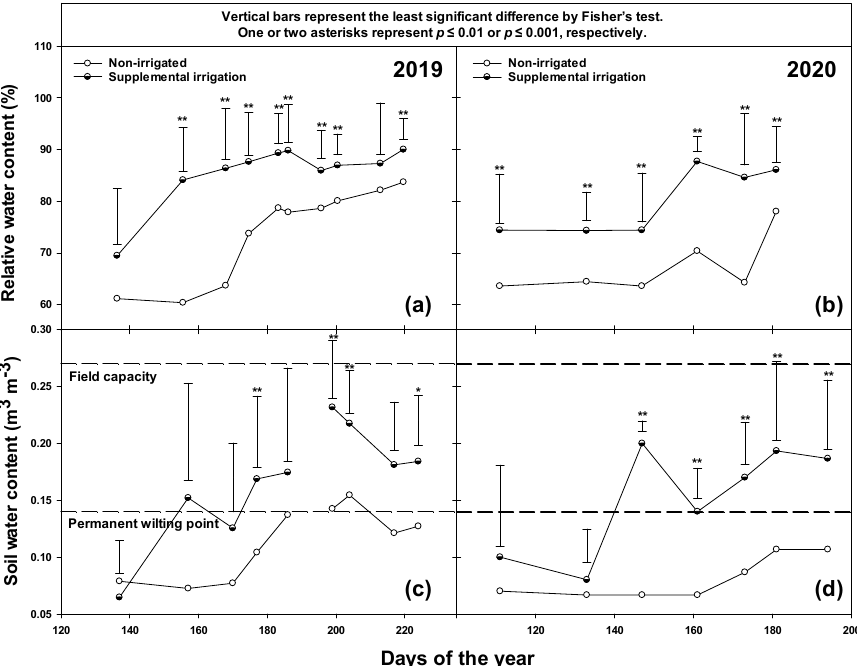
Figure 2. Changes in relative water content of cladodes ( a , b ) and soil water content ( c , d ) in experi- mental plots of ‘Roja Lisa’ cactus pear plants undergoing no irrigation or supplemental irrigation in 2019 and 2020. The data were collected in the commercial orchard ‘Las 100 Hectáreas’. La Victoria, Pinos, Zacatecas, Mexico.